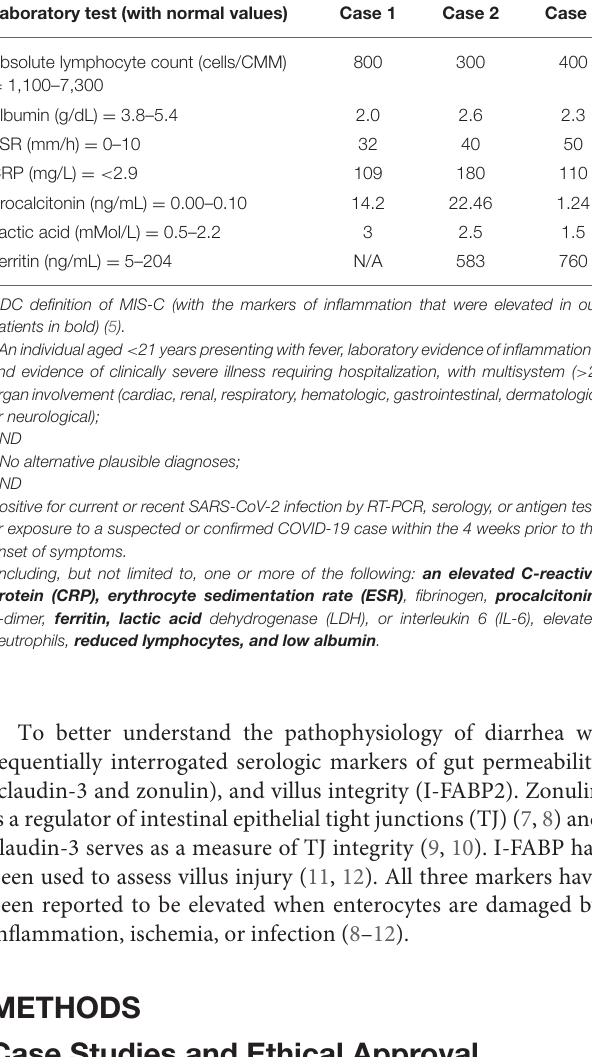
TABLE 1 | Elevated levels of markers of inflammation in our cohort of patients. Laboratory test (with normal values) Case 1 Case 2 Case